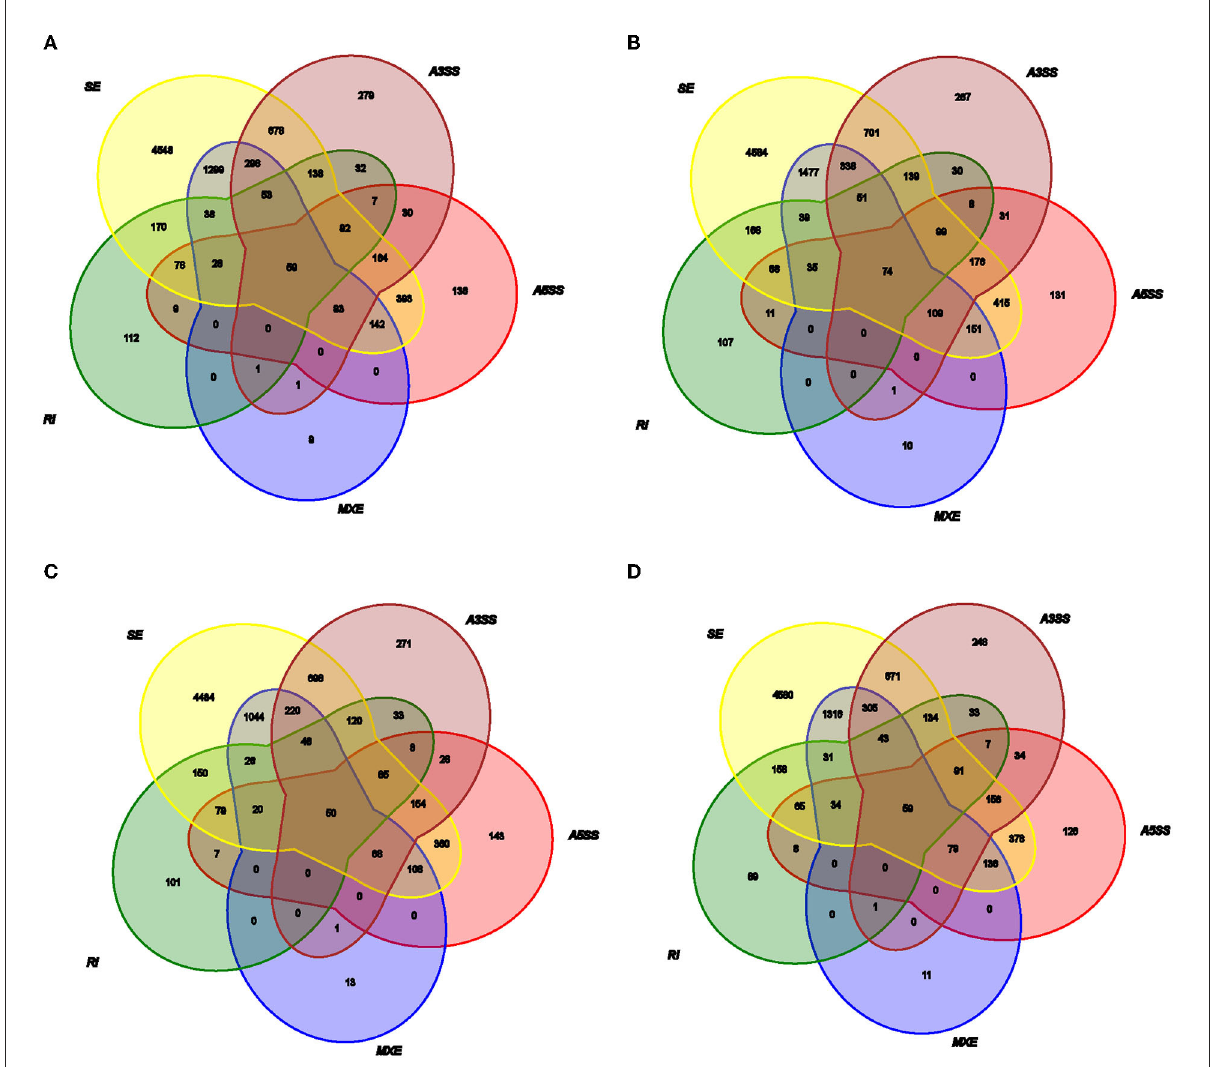
FIGURE2 Relationship of the different types of AS events in (A) TL, (B) TN, (C) LL, and (D)